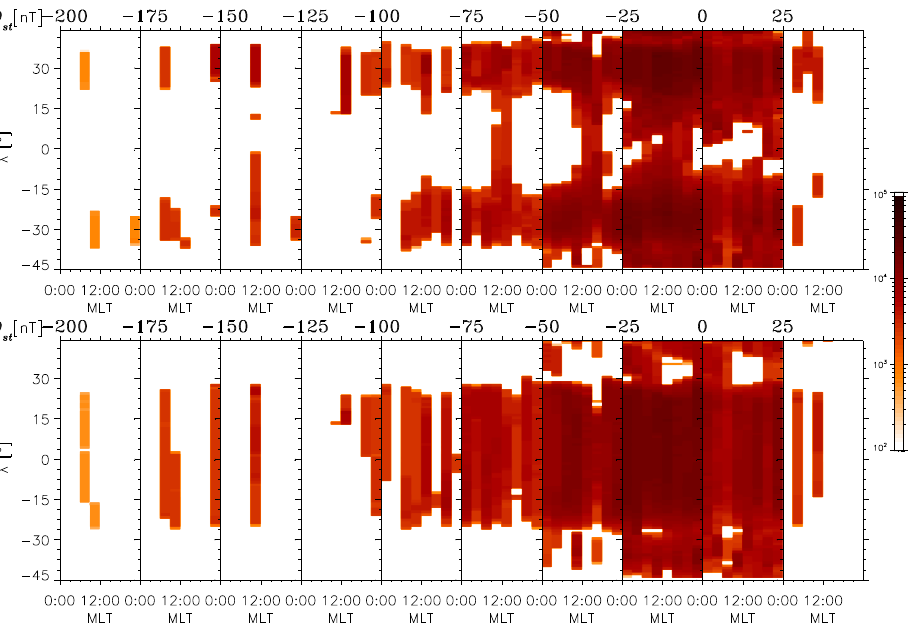
Figure 5. Data coverage (MLT as a function of λ ) of the Cluster data set employed in this study, and described in detail in Agapitov et al. (2013), for different ranges of the Dst (Disturbance storm time) and K p indices (top/bottom panel corresponds to K p < 3/ K p > 3, respectively.